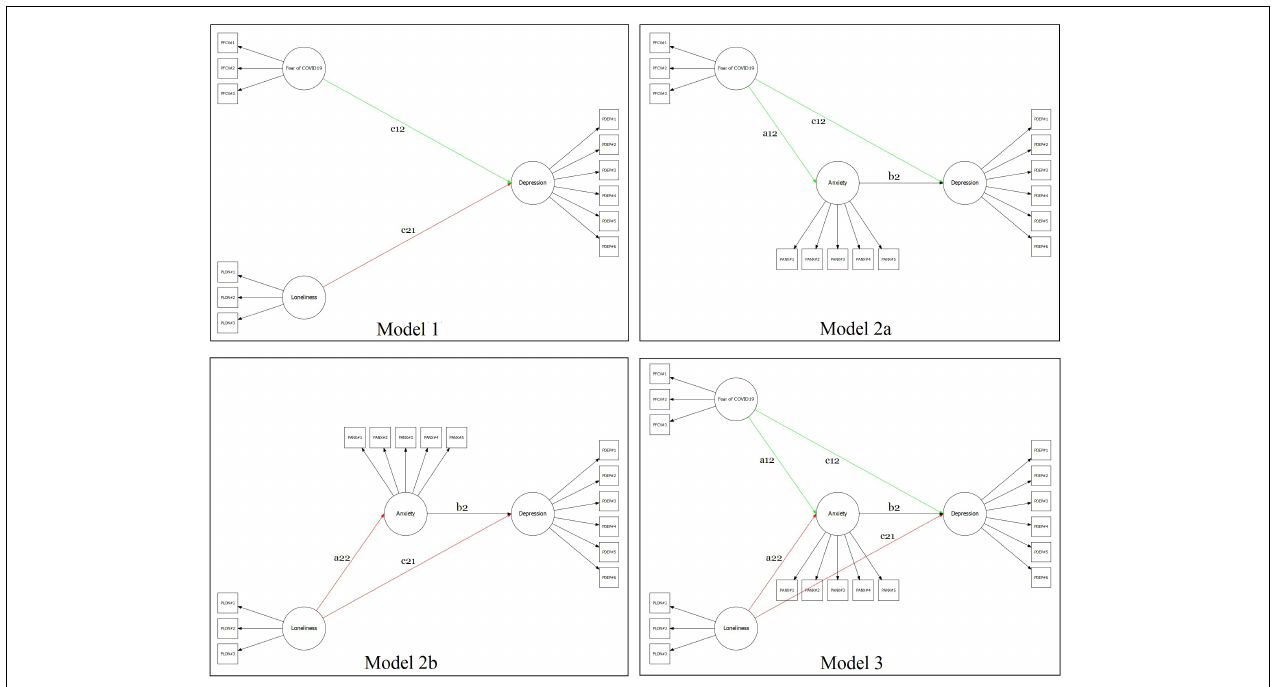
FIGURE 1 | Graphical representation of the several mediation models